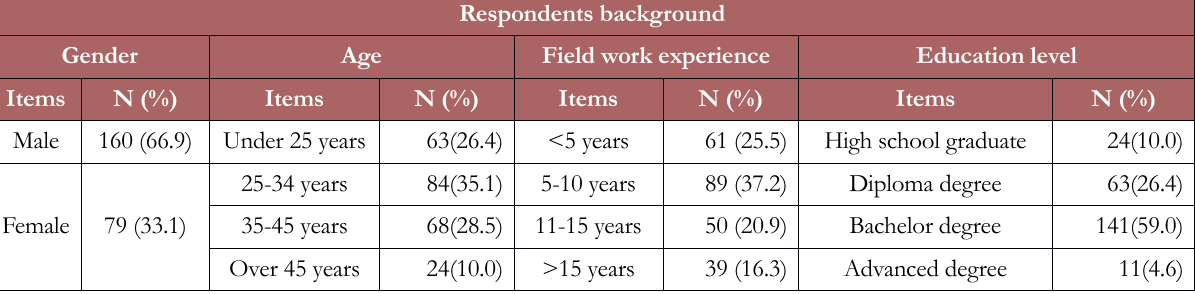
Table 3. Respondents background (N =